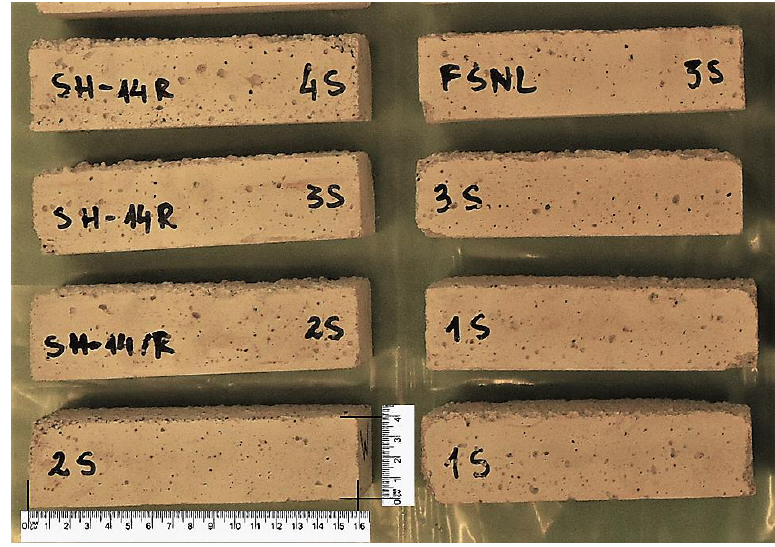
Figure 3. Samples after the frost resistance test.